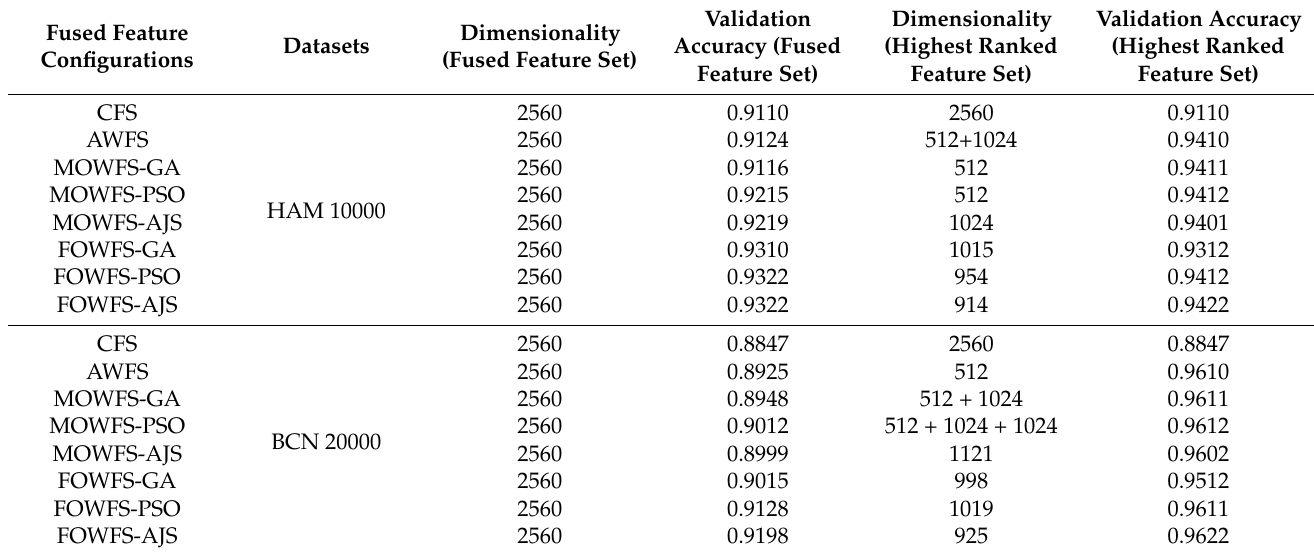
Table 4. Validation accuracy of fused feature sets vs. ranked feature sets based on DT.